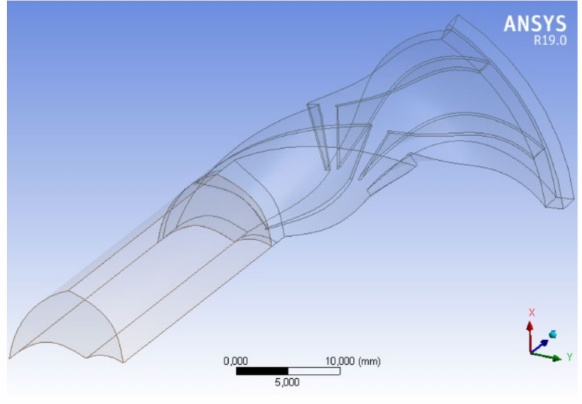
Figure 9. Tandem rotor CFD fluid domain.